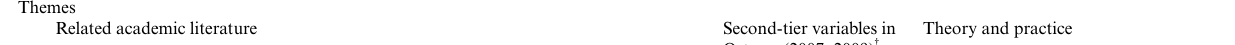
Table 3 . Themes from the research literature not found in study participants’